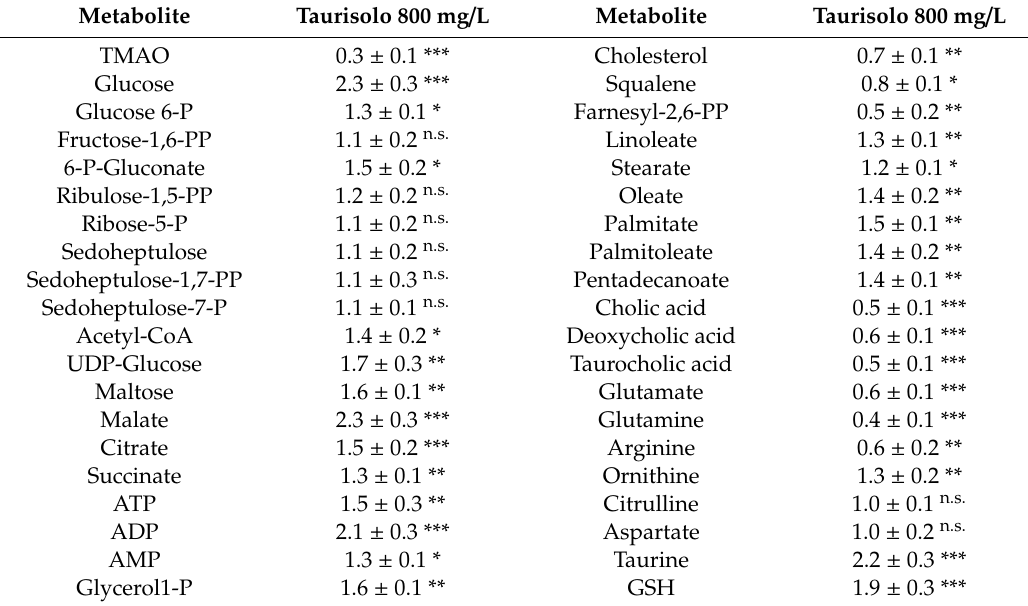
Table 2. Taurisolo reprograms metabolism of mice